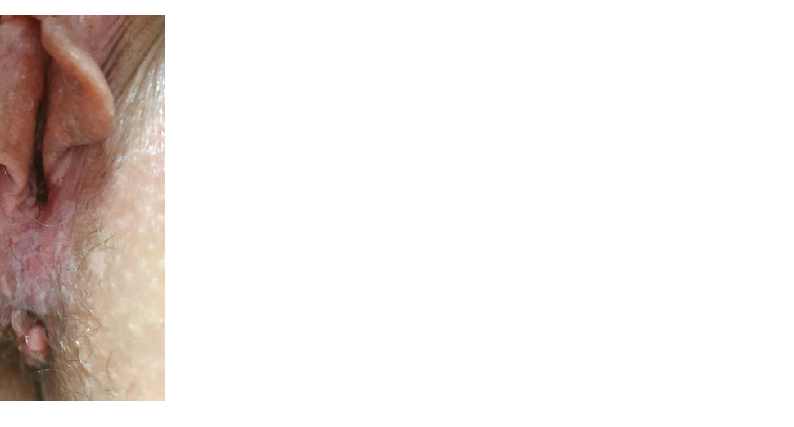
Figure 1. Extension of vulvar HSIL to the perianal area (after the application of acetic acid). Examination of the vulva has several stages.